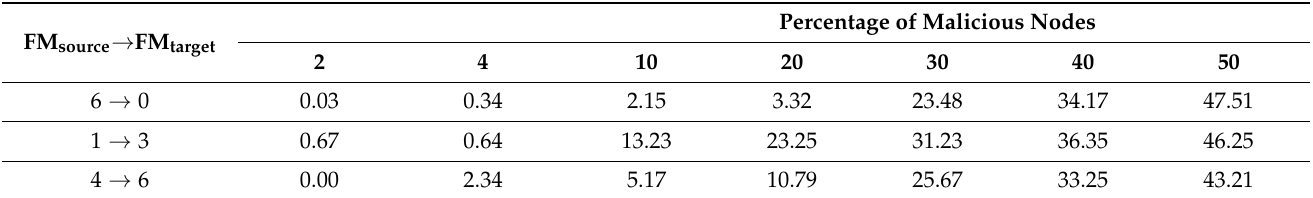
Table 2. Loss in source → target with different counts for the Fashion-MNIST